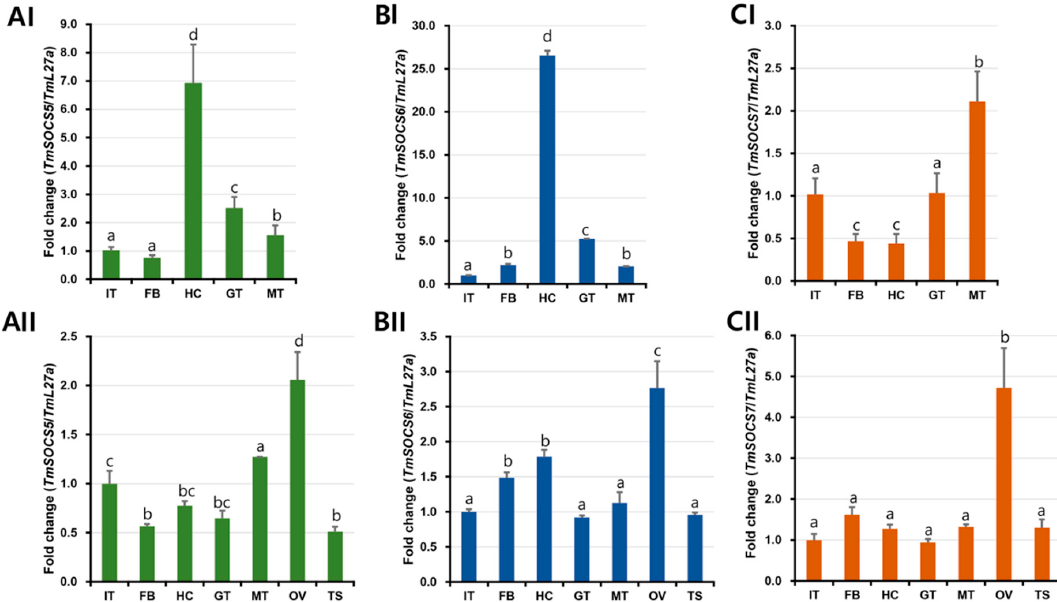
Figure 9. Tissue distribution of TmSOCS transcripts in T. molitor : ( A ) Distribution of TmSOCS5 transcripts in larval (AI) and adult tissues (AII); ( B ) distribution of TmSOCS6 transcripts in larval (BI) and adult tissues (BII); ( C ) distribution of TmSOCS7 transcripts in larval (CI) and adult tissues (CII). Tissues are abbreviated as follows: IT, integument; FB, fat body; HC, hemocytes; GT, gut; MT, Malpighian tubules; OV, ovary; TS, testis. RpL27a ( T. molitor ) was included as an internal control to normalize RNA levels among samples. Vertical bars represent mean ± S.E. Different letters (a, b, c, d, and bc above bars) indicate significant differences among groups ( p < 0.05).